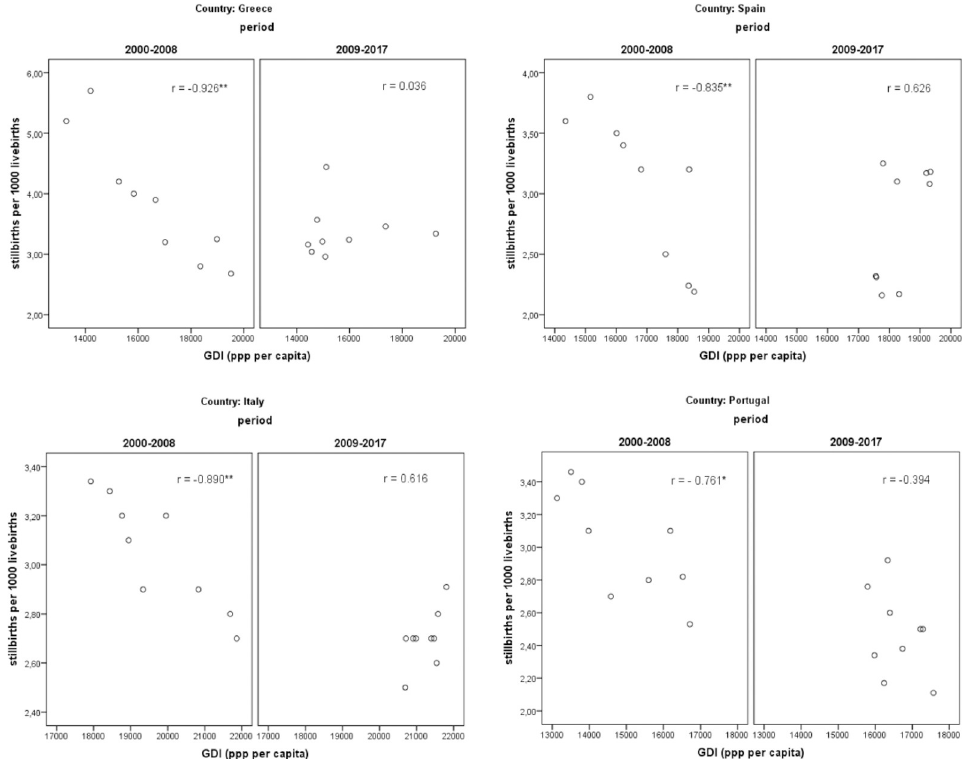
Fig 2. Scatter plots and correlation coefficients between stillbirth ratios and Gross Disposable Income (GDI). ( �� statistically significant at 0.01 � statistically significant at 0.05).